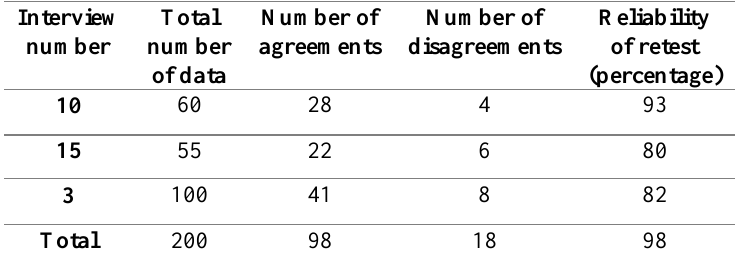
Table 1. Reliability calculation table